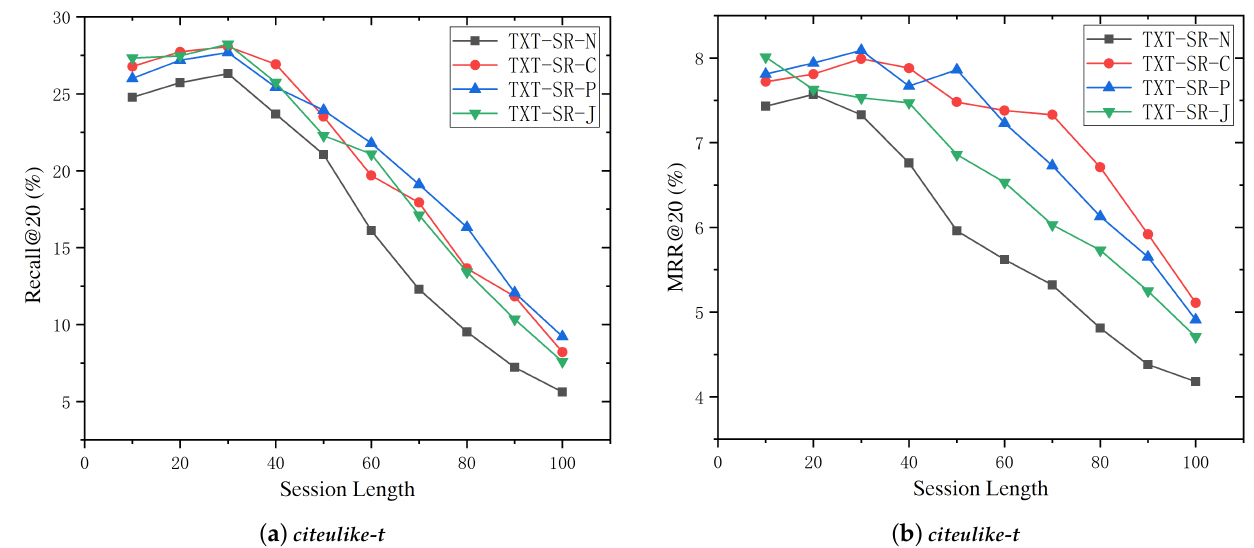
Figure 7. Performance comparison of different methods with different session lengths on citeulike-t